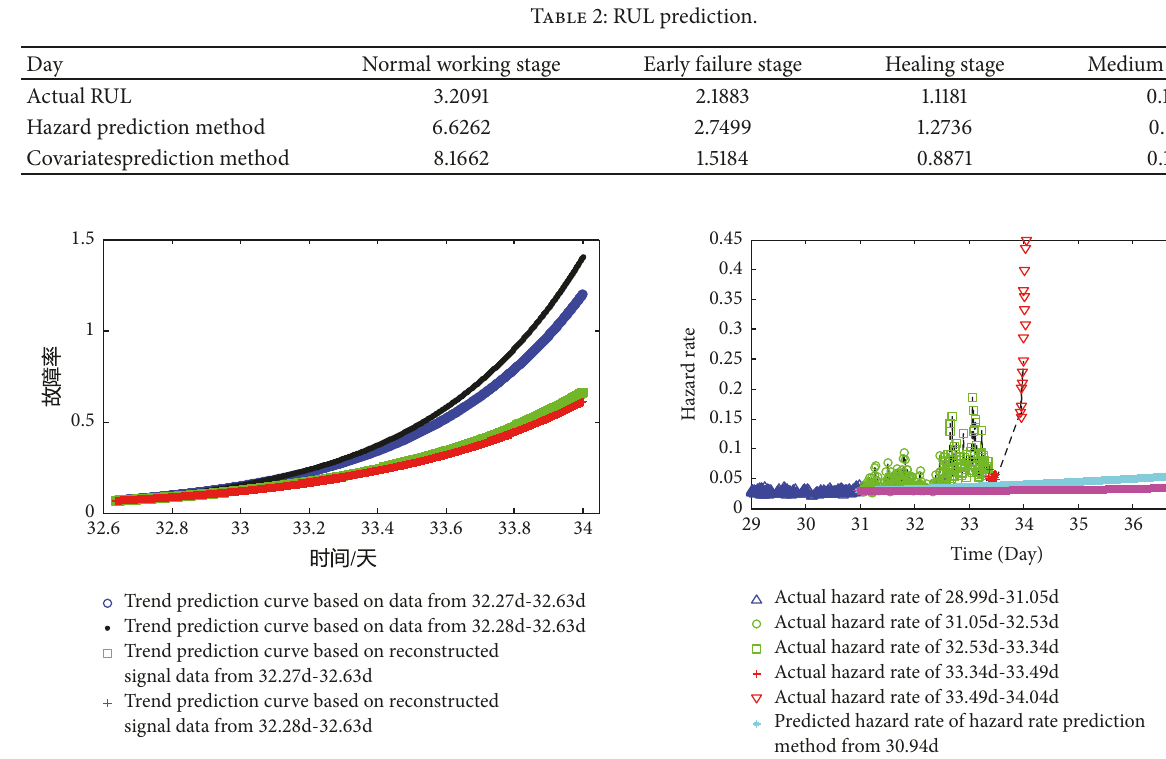
Figure 12: The comparison results of trend prediction curveof peri- od (c).